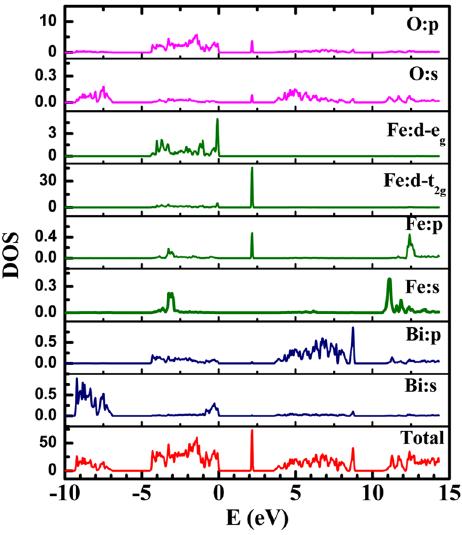
Figure 10. Partial density of Bi (s and p), Fe (s, p, and d) and O (s and p) states in sillenite Bi 12 FeO 20 .